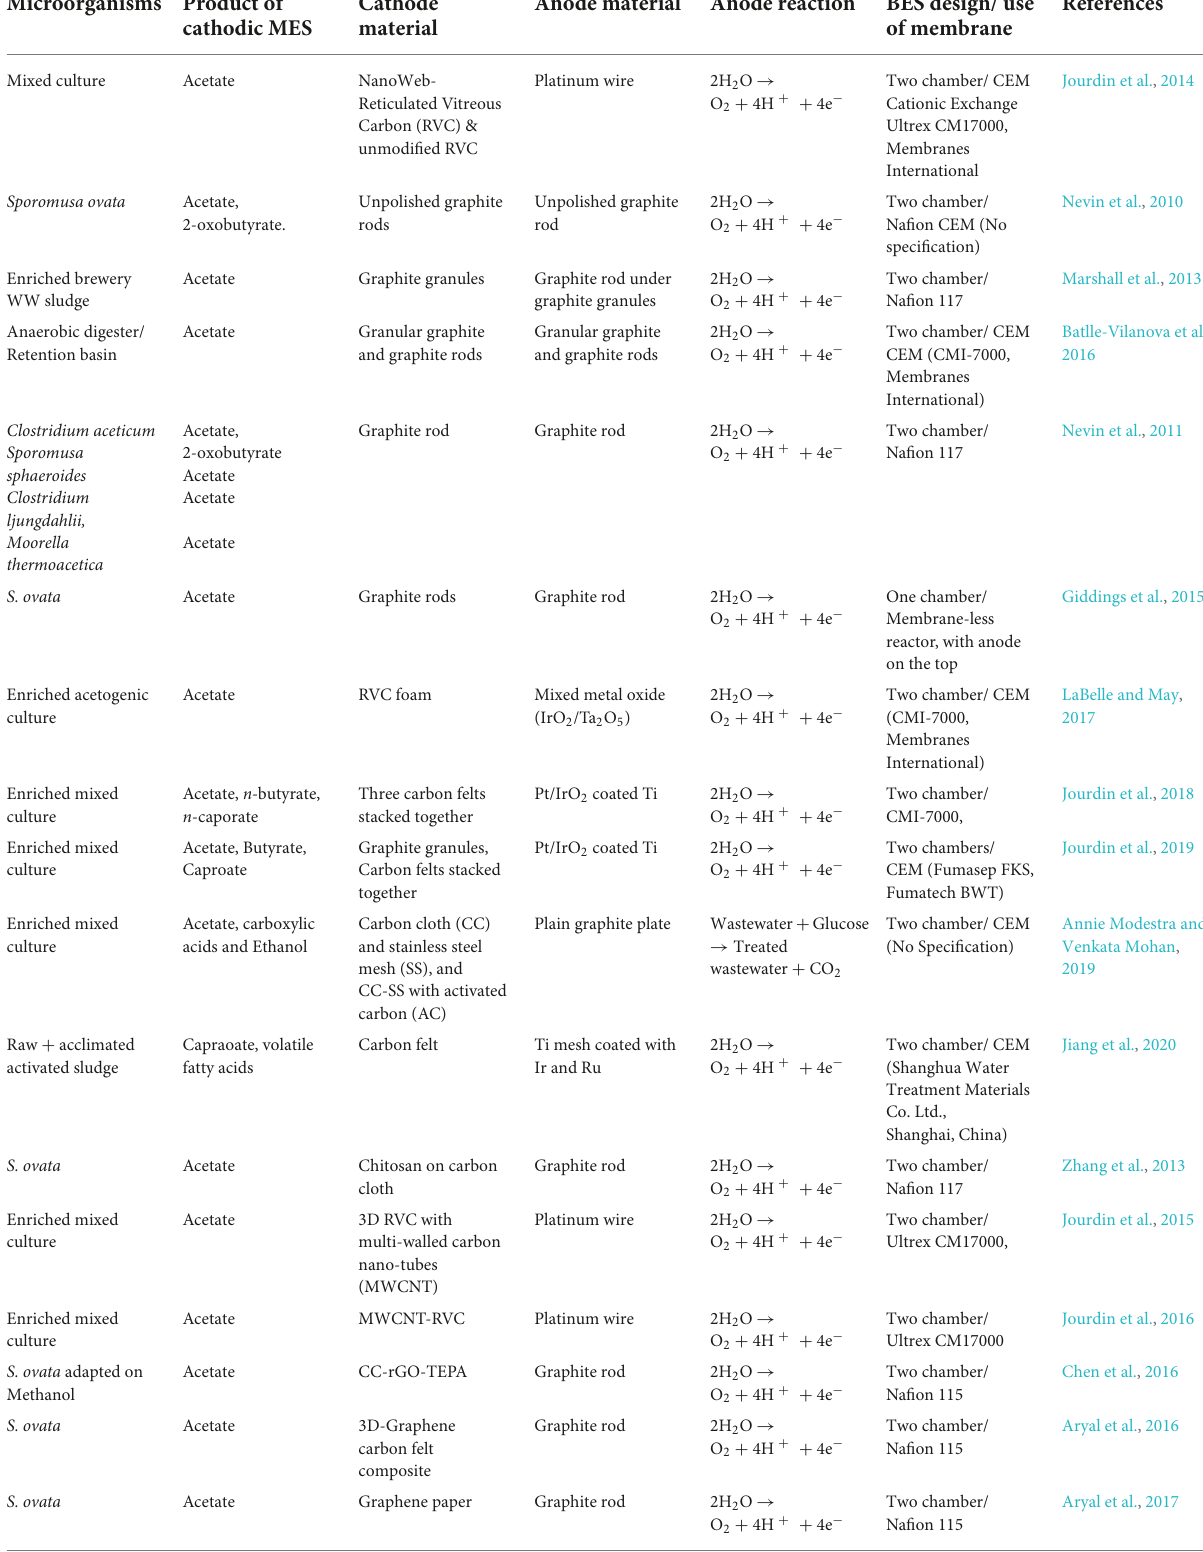
TABLE 1 Collection examples of cathodic microbial electrosynthesis studies using CO 2